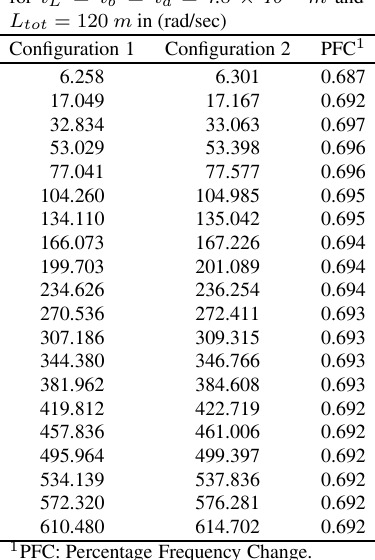
Torsional natural frequencies of a radar truss for t L = t b = t d = 4.8 × 10 − 4 m